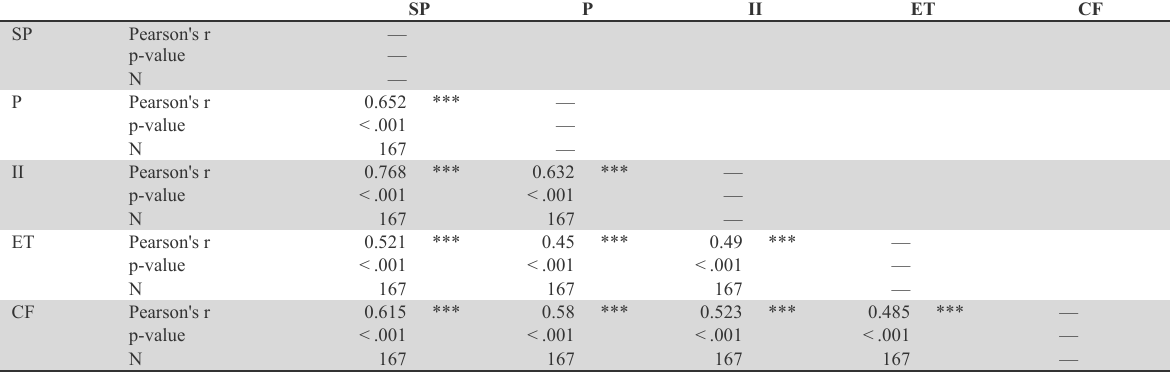
Constructs Correlation Matrix of Strategic Planning, Productivity, Important Innovation Education and Training, and Cus- tomer Focus